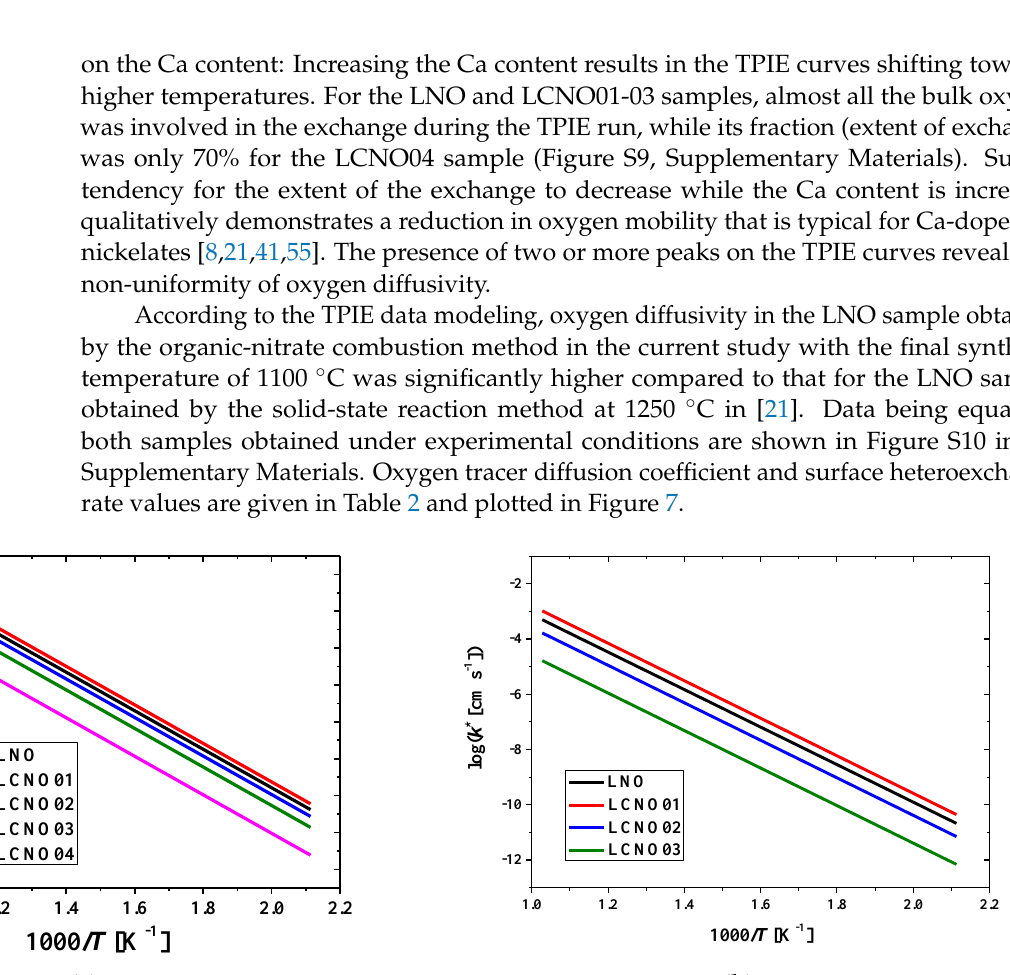
Table 2. Oxygen heteroexchange reaction with a rate R , oxygen diffusion (normalized on particle size) via fast channel